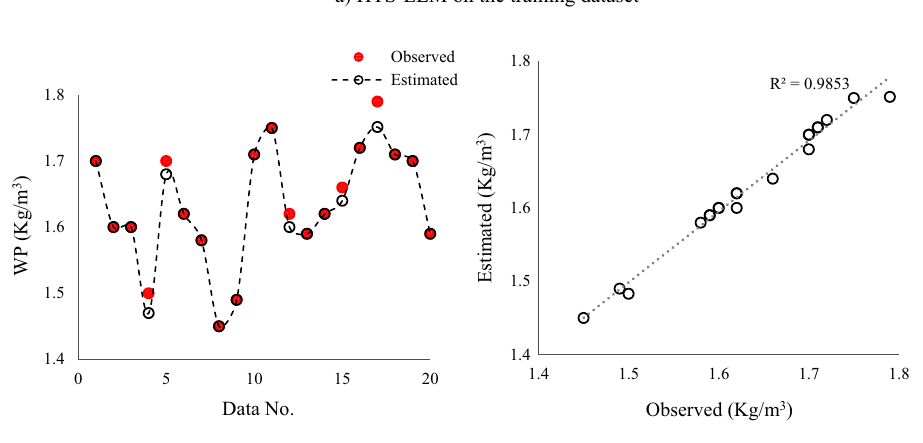
Table 9 Comparison of intelligent techniques in estimating yield and WP